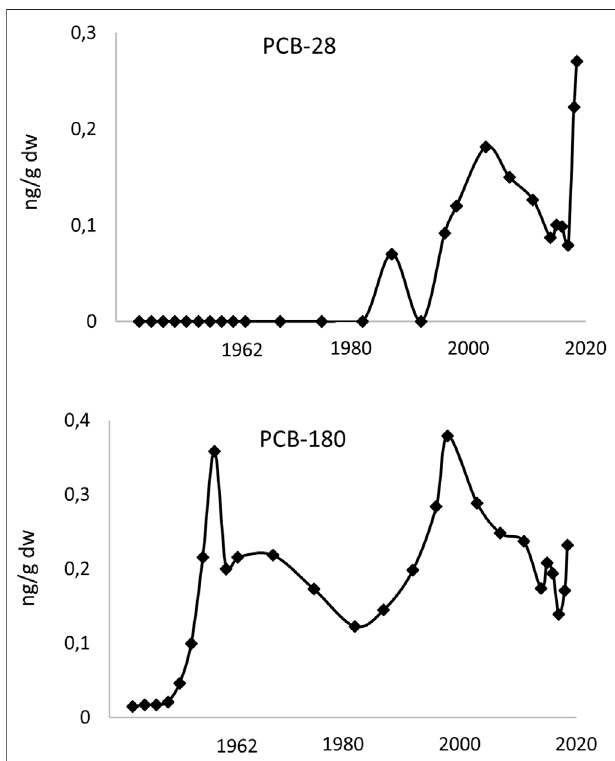
FIGURE3 | ConcentrationofPCB-28and PCB-180 in sedimentslayers dated from before 1962 – 2019.